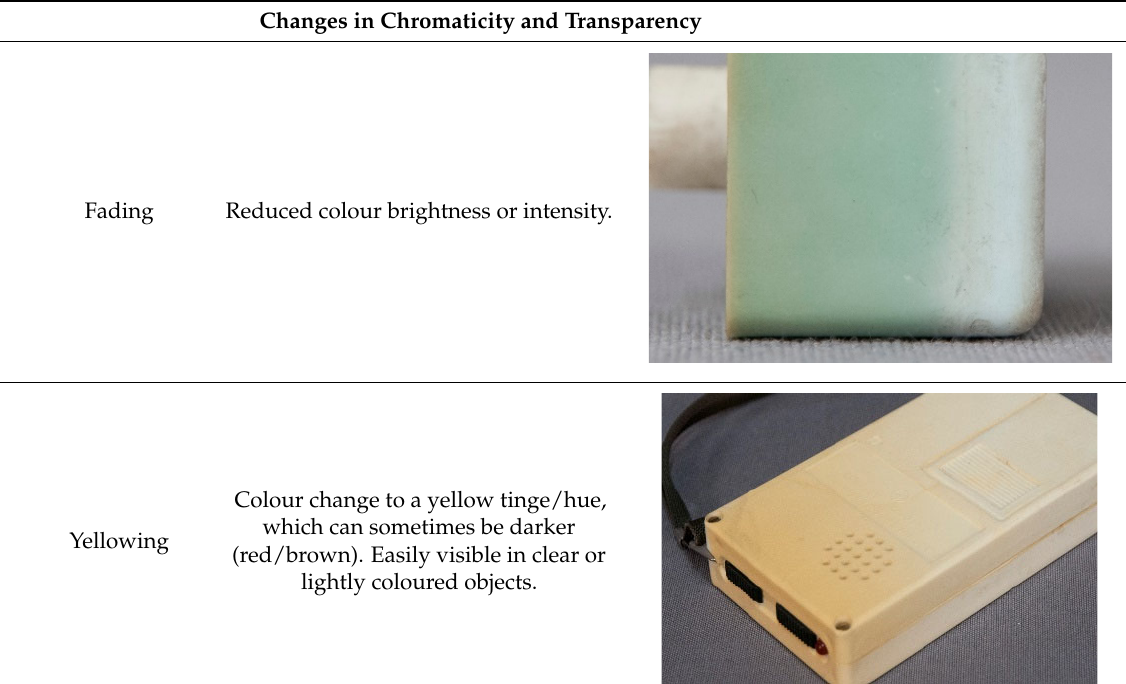
Table 3. Definitions of the category ‘changes in chromaticity and transparency’.